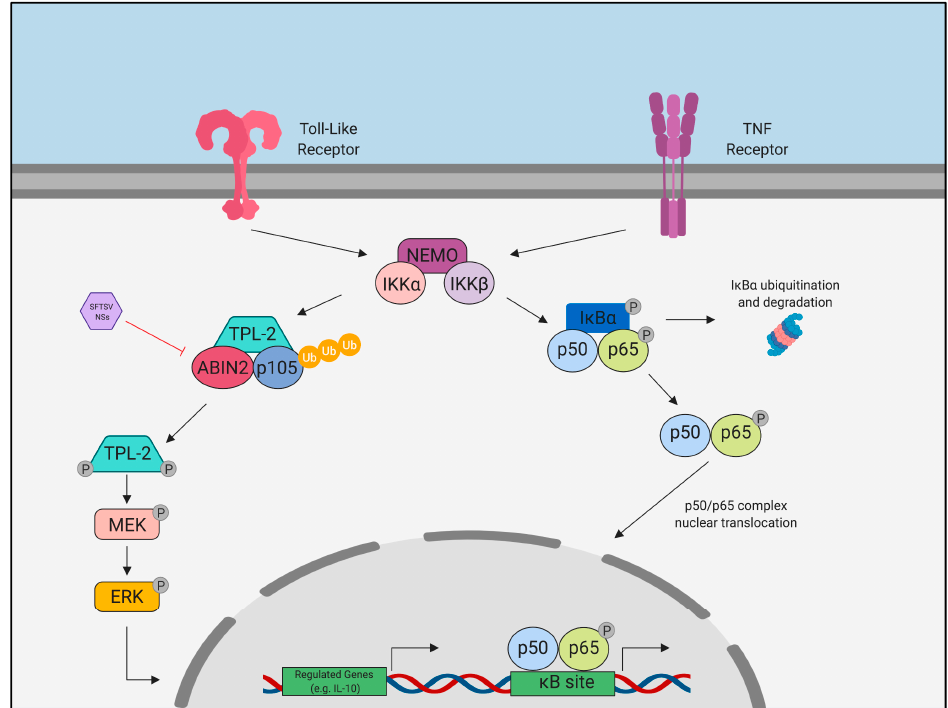
Figure 4. Induction of the TPL2 signaling pathway by SFTSV NSs. The SFTSV NSs binds ABIN2, an inhibitor of TPL ‐ 2 and p105, which frees the complex to induce downstream MEK/ERK signaling and production of regulated genes, such as IL ‐ 10.